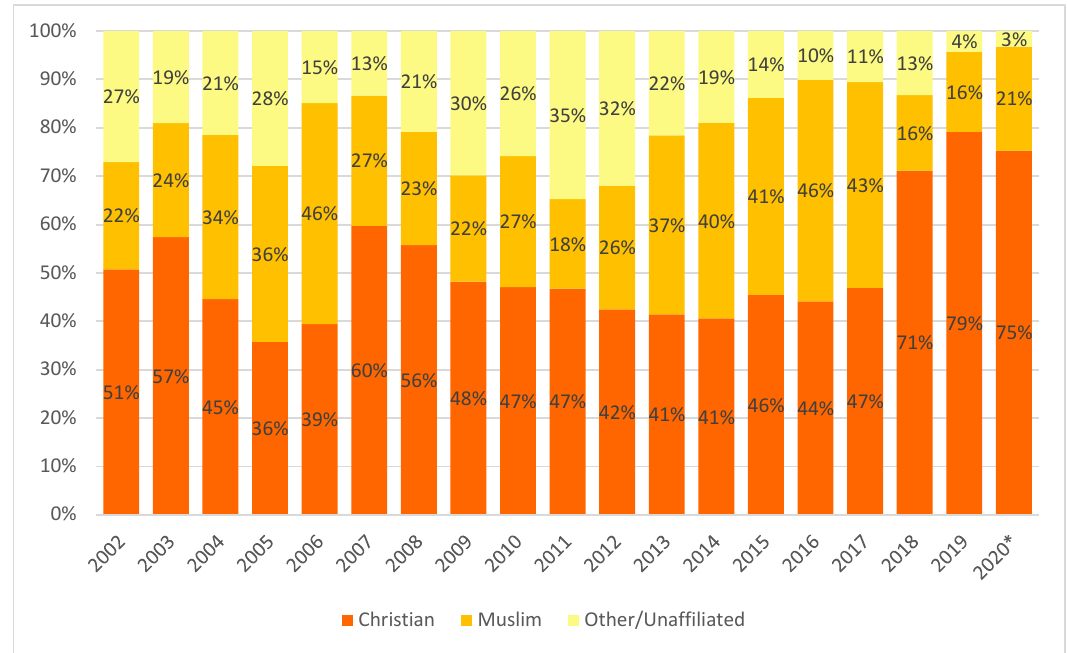
Figure 2. Religious affiliation of refugees admitted to the United States, 2009–2020. * Figures for FY 2020 represent partial-year data; 1 October 2019 to 5 March 2020. Source: U.S. Department of State, Bureau of Population, Refugees, and Migration (PRM) Refugee Processing Center.